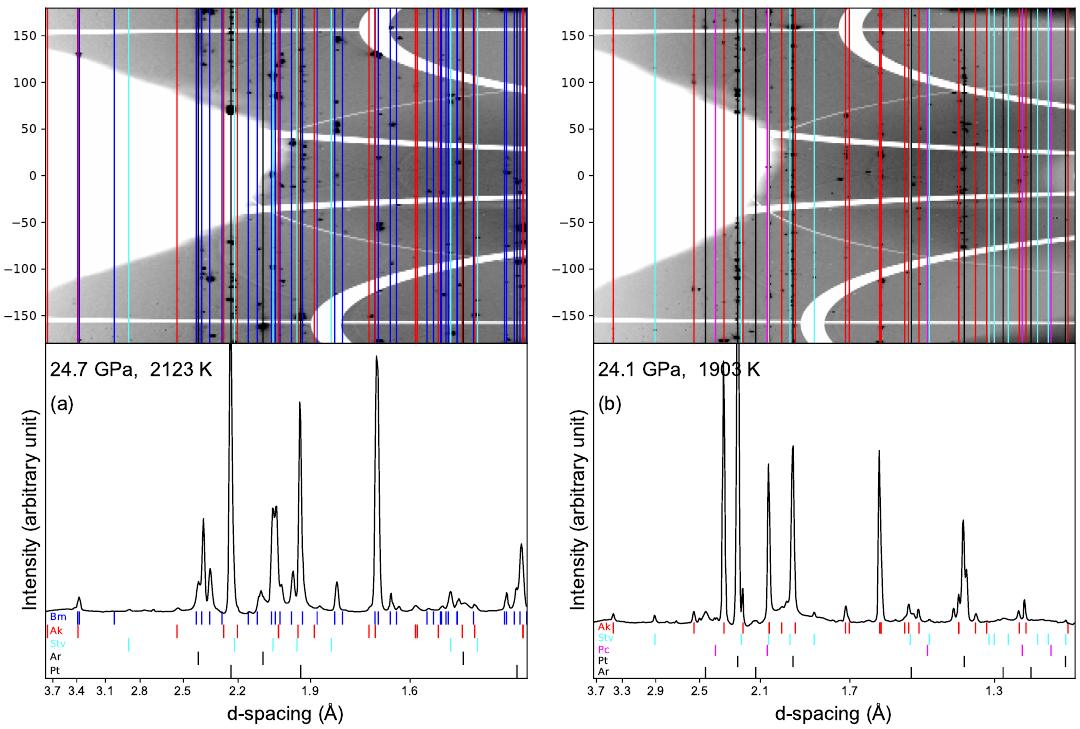
Figure 3. Two-dimensional diffraction images of LHDAC data (top) with integrated 1D diffraction patterns (bottom): ( a ) the formation of Bm, shown in blue, across the Mj/Bm phase boundary and ( b ) the stability of Ak and absence of Bm. We provide P − T conditions of the diffraction measurements. The colored vertical bars in the 2D image and the colored ticks in the 1D pattern show the diffraction peak positions of different phases. We found some weak diffraction features possibly from Ak and Stv (stishovite) in Figure 3a and Stv and Pc (periclase) in Figure 3b. They are likely formed as transient phases due to kinetics and differential elemental diffusion during phase